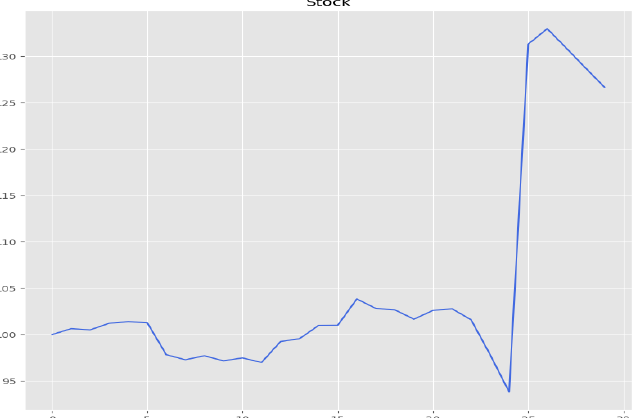
Figure 5. Under the discretised rough Bergomi model, the stock can jump by more than ± 30% in a single time step. This stock path caused extreme loss of − 27.73 seen in Figure 4.